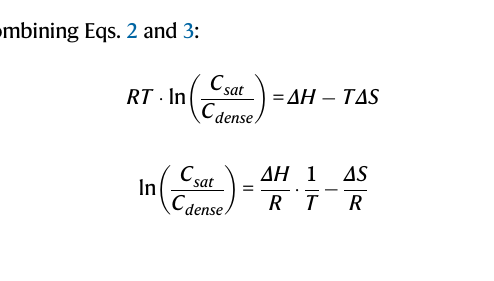
Dynamic Light Scattering (DLS) with increasing temperature until a sharp increase of light scattering intensity was observed, which indicates phase separation. The temperature at which phase separation had just occurred was taken as the transi- tiontemperature , T . d DLSanalyseswererepeatedatindicatedNaClconcentrations ( C NaCl ) to determine T ,whichwasplotted against[prf.GLFG 52×12 ].Measurementfor each condition was repeated three times with independent samples, and mean